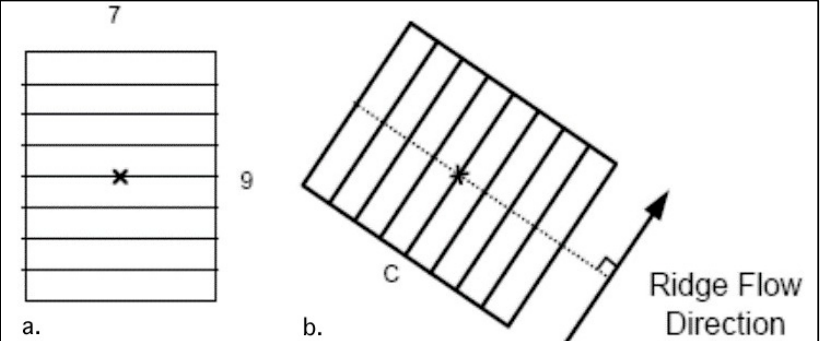
Figure 8. Ridge flow detection approach. ( a ) 7 × 9 grid is used to sum values. ( b ) Rotated grid centered on the pixel to which the sum will acrue [32].